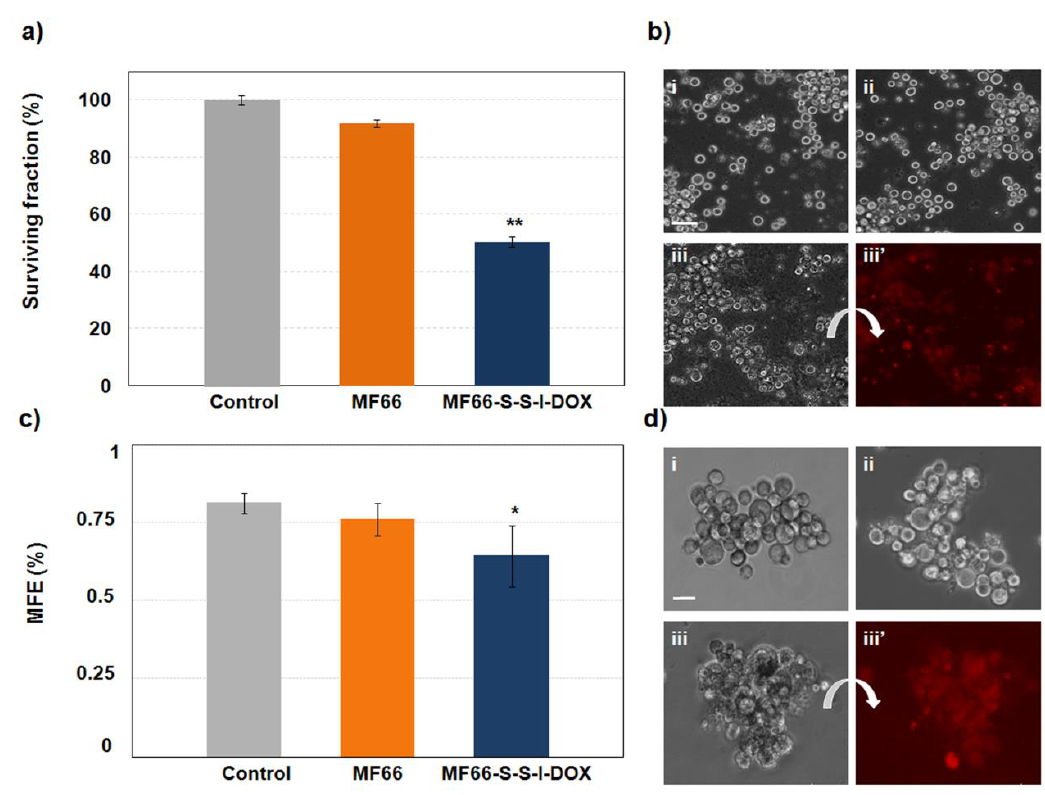
Figure 8. Analysis of MF66-S-S-I-DOX in primary metastatic patient-derived breast cancer cells. ( a ) Cellular viability assessed by trypan blue performed 24 h after the 24 h incubation. ( b ) Images of (i) control cells or incubated with (ii) bare MF66 or (iii, iii’) MF66-S-S-I-DOX in phase contrast and fluorescence microscopy, respectively, at the same post-incubation time. Scale bar: 50 µ m. ( c ) Quantification of mammosphere forming e ffi ciency analysed 7 days after cell incubation for 24 h with MNPs. ( d ) Images of mammospheres from (i) control cells or incubated with (ii) bare MF66 or (iii, iii’) MF66-S-S-I-DOX in phase contrast and fluorescence microscopy, respectively at the same post-incubation time. Scale bar: 25 µ